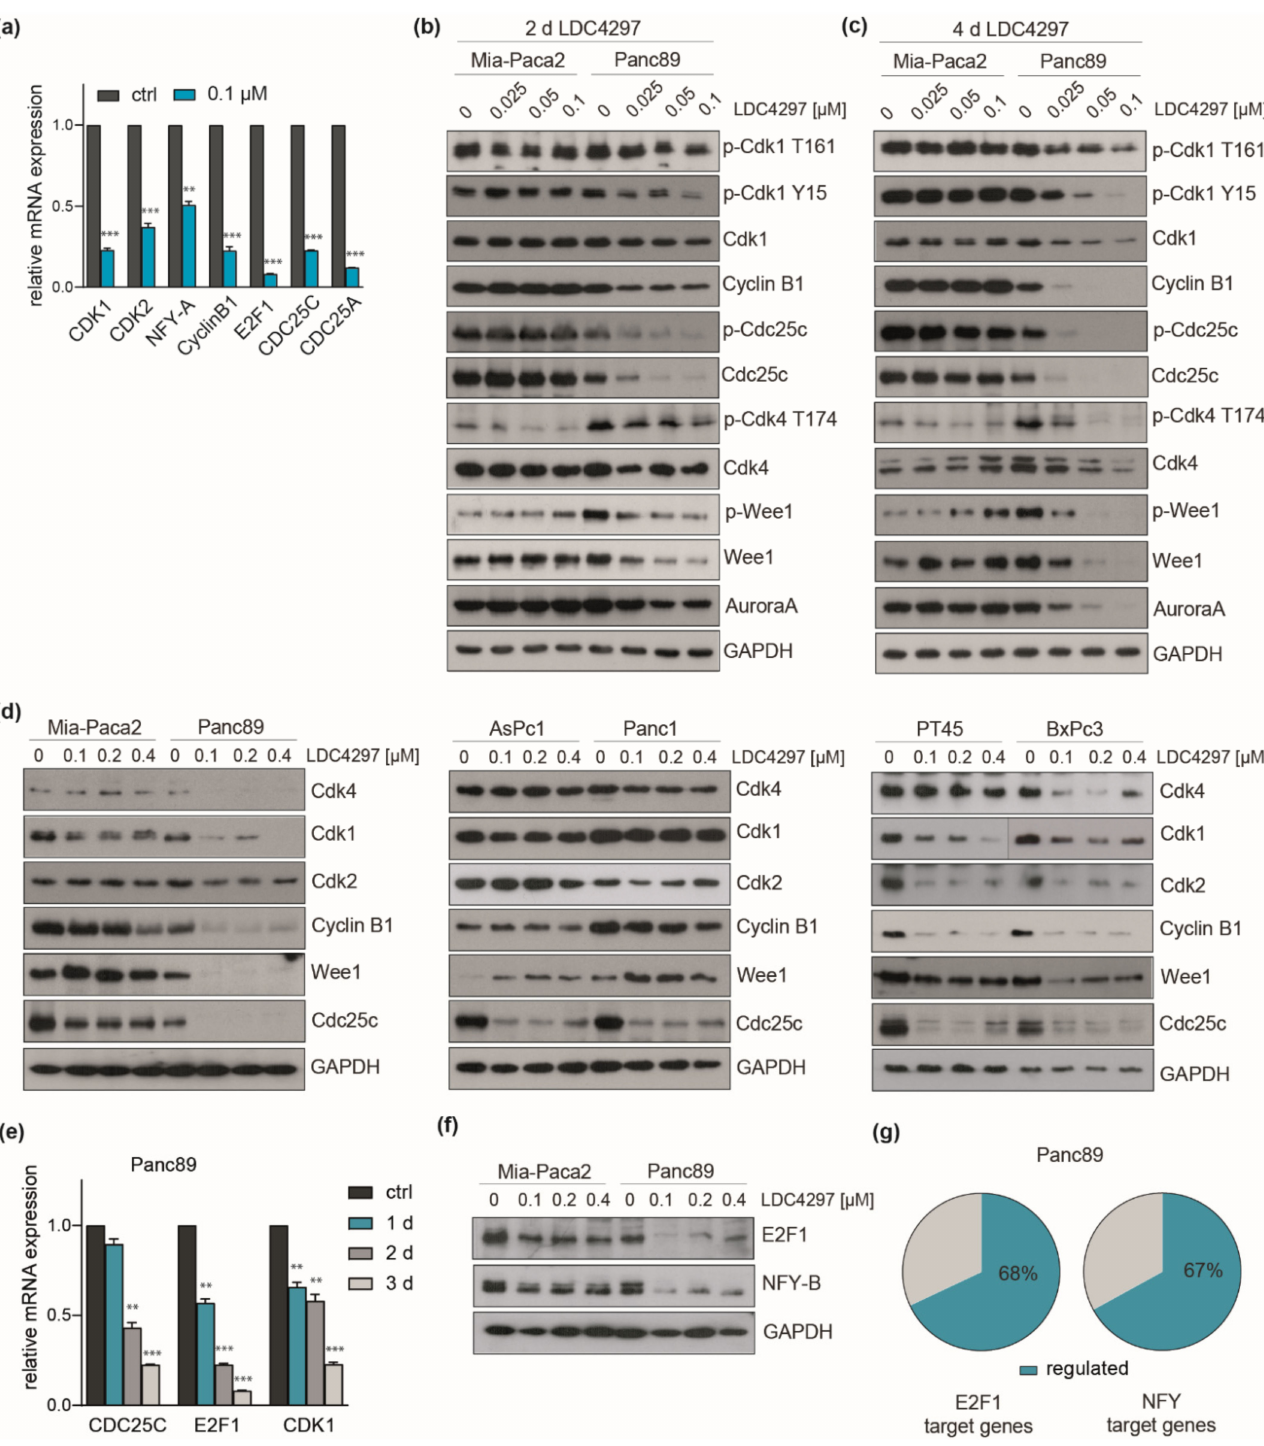
Figure 7. Cell line-specificity of cell cycle regulator RNA and proteins. ( a ) RT-qPCR analysis of Panc89 RNA after treatment with 0.1 µ M LDC4297 for 3 days. Shown is the mean ± SD ( n = 3). ( b , c ) Western blot analysis of Mia-Paca2 and Panc89 cells treated for 2 days ( b ) or 4 days ( c ) with